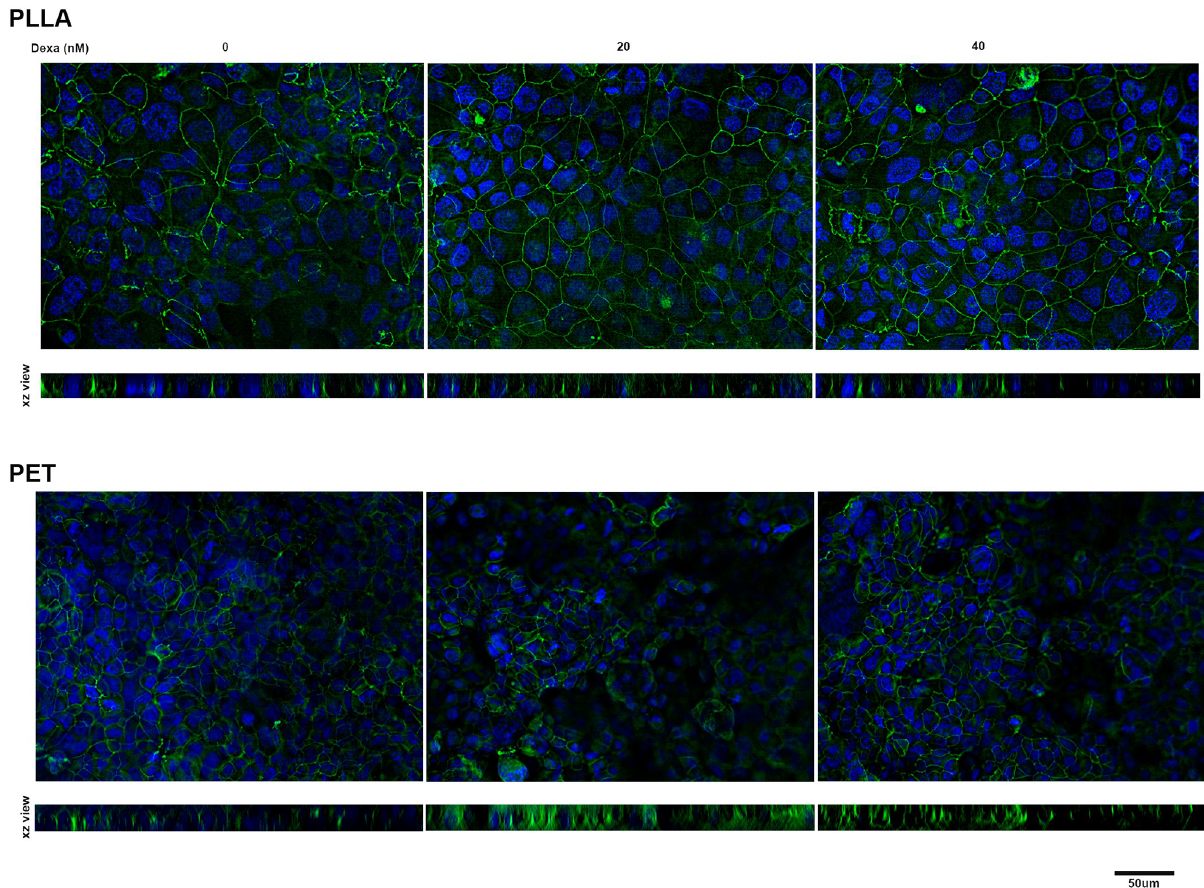
Fig 3. Immunofluorescent images showing tight junctions immunostained using an anti-occludin 488 Alexa Fluor conjugated antibody. Cells were cultured for 5 days on PLLA (upper images) or PET (lower images) membranes without or with dexamethasone treatment (20 and 40 nM). Data are representative of 2 independent